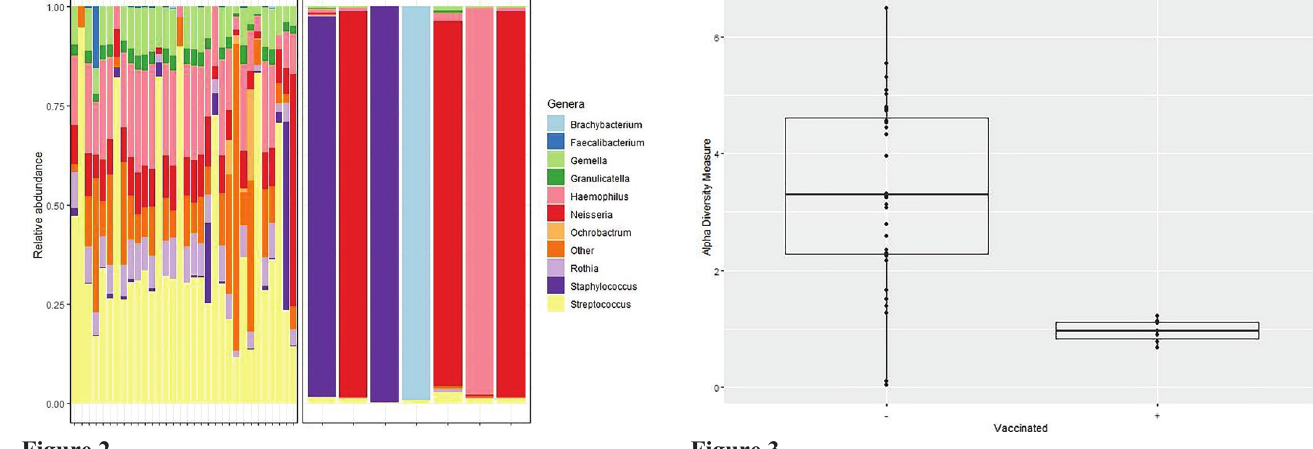
According to the distribution of microorganisms that make up the cerebrospinal fluid in patients with bacterial meningitis of unknown etiology, a clear distinction is made into two